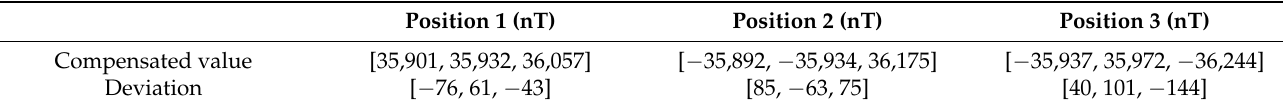
Table 8. Compensated